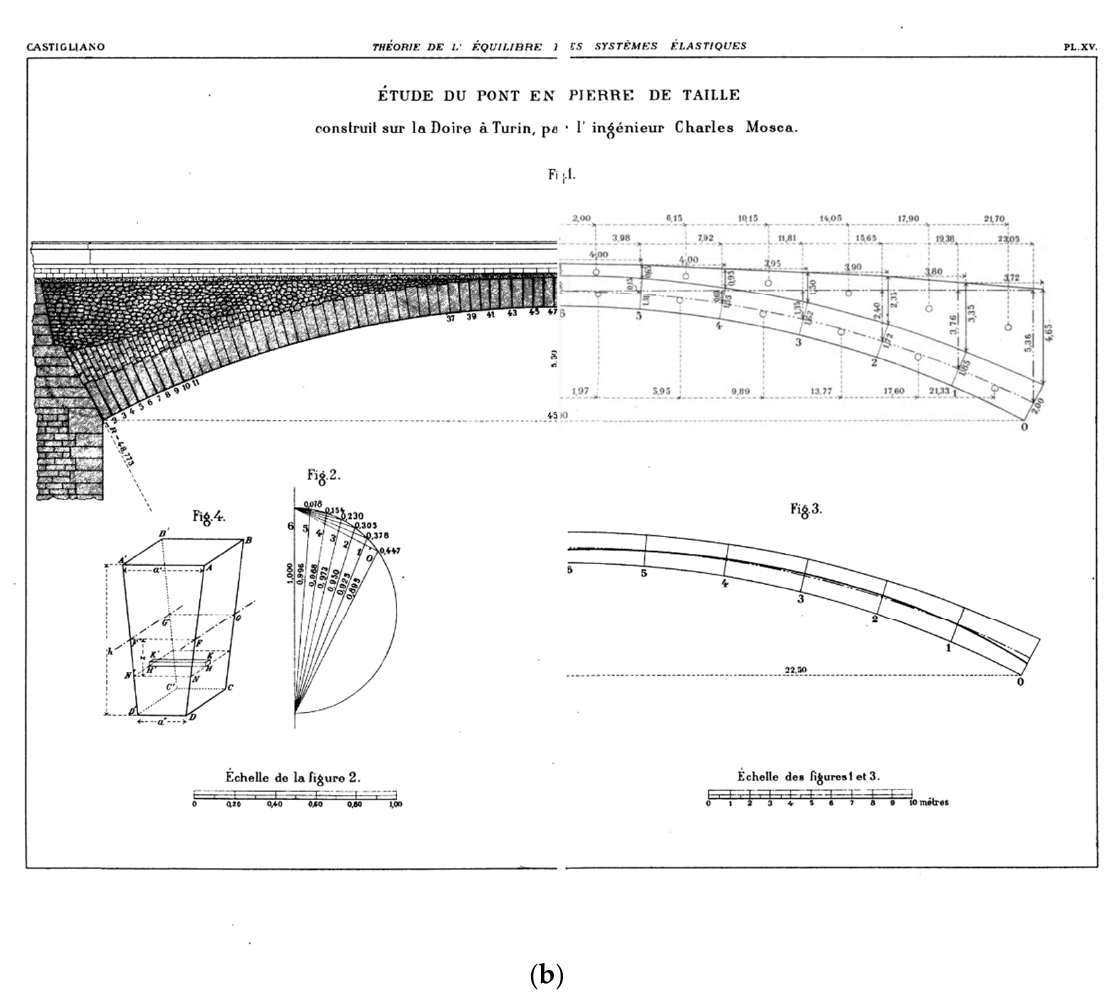
Figure 7. Mosca Bridge, Turin (Italy): Overview ( a ); Arch sketch by Alberto Castigliano, 1879 [31] ( b ). Table 1. Geometrical and mechanical parameters of the analyzed arch